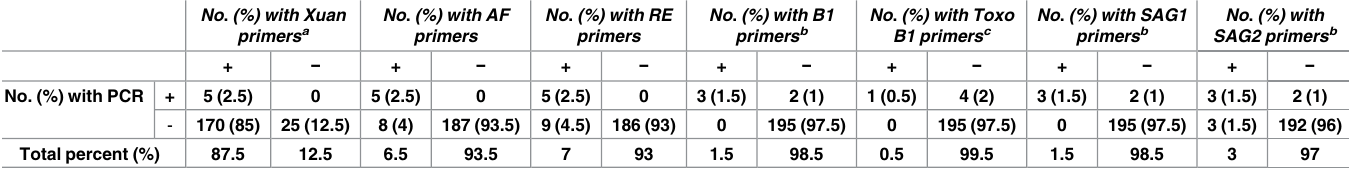
Table 2. Comparison of the conventional PCR and LAMP for detection of T . gondii in blood samples from pregnancy. No . (%) with Xuan No . (%) with AF primers a